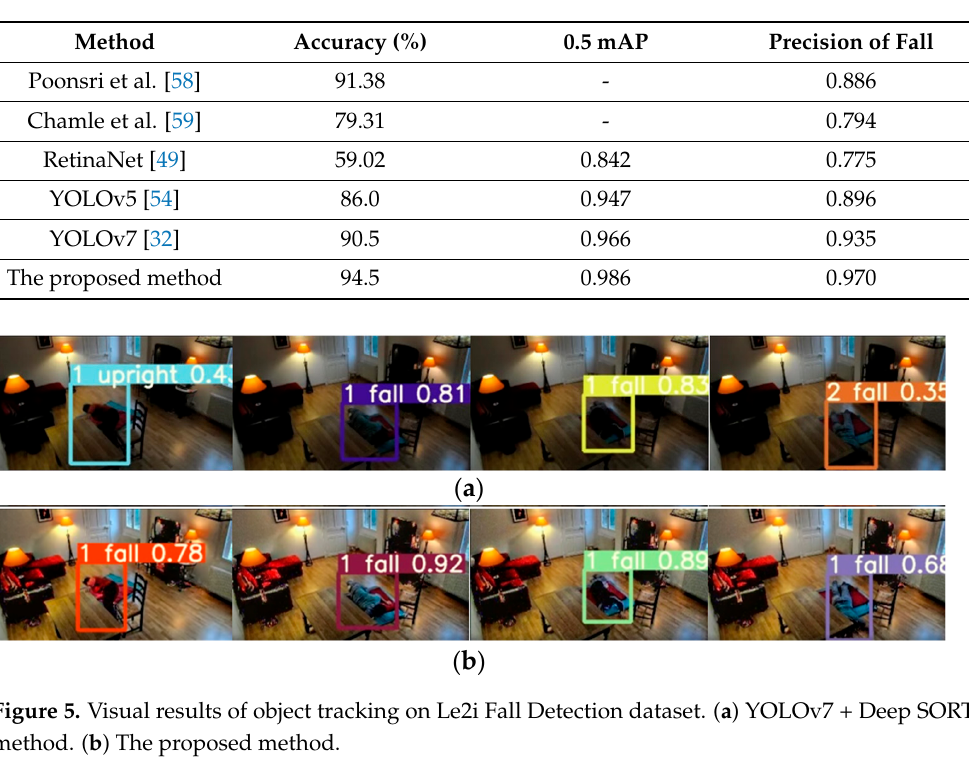
Table 5. p -Values of the McNemar’s significance test on UR-Fall dataset.